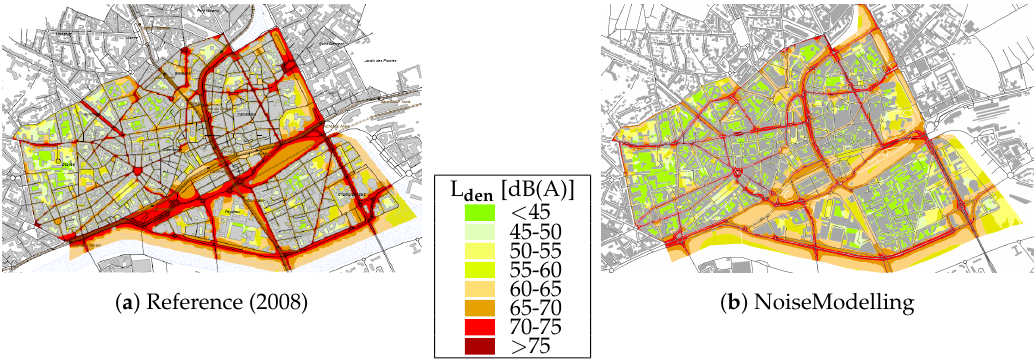
Figure 12. Comparison of the road traffic noise L den maps: ( a ) provided by Nantes Métropole (2008); and ( b ) produced with the proposed approach for down-town Nantes for a 2nd-order sound reflection ( n ref = 2), a 1st-order sound diffraction ( n dif = 1), a critical radius d max = 750 m, a distance in searching for façades d lim = 50 m, a roads width of 1.5 m, a receivers densification value d road = 2.8 m and a wall absorption value α vert = 0.23.